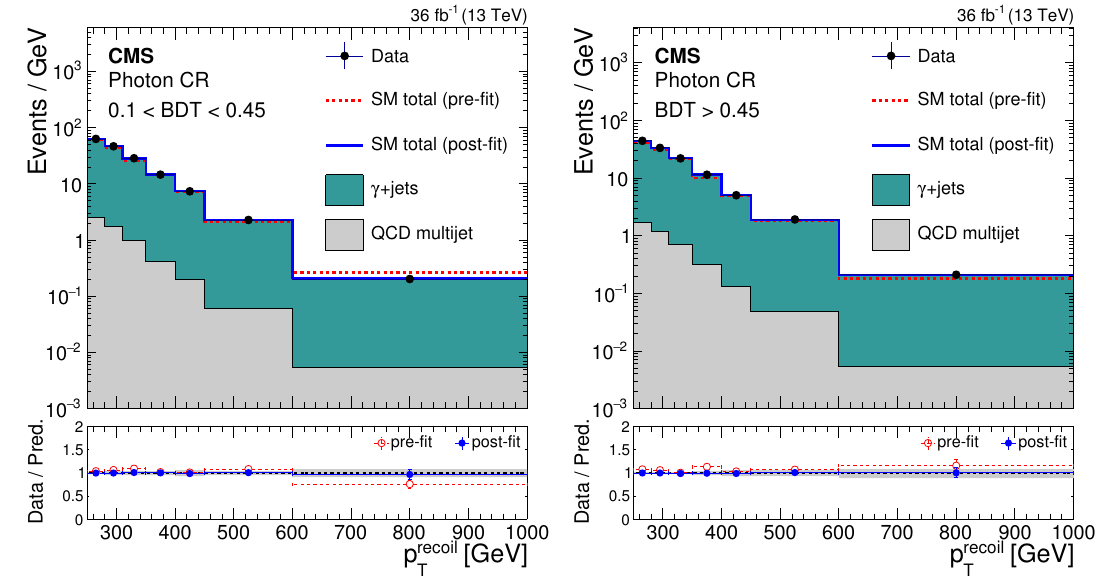
Figure 5 . Comparison between data and SM predictions in the photon control regions before and after performing the simultaneous (cid:12)t to the di(cid:11)erent control regions and signal region. Each bin shows the event yields divided by the width of the bin. The left (right) (cid:12)gure corresponds to the loose (tight) category of the control region. The blue solid line represents the sum of the SM contributions normalized to their (cid:12)tted yields. The red dashed line represents the sum of the SM contributions normalized to the prediction. The stacked histograms show the individual (cid:12)tted SM contributions. The lower panel of each (cid:12)gure shows the ratio of data to (cid:12)tted prediction. The gray band on the ratio indicates the one standard deviation uncertainty on the prediction after propagating all the systematic uncertainties and their correlations in the